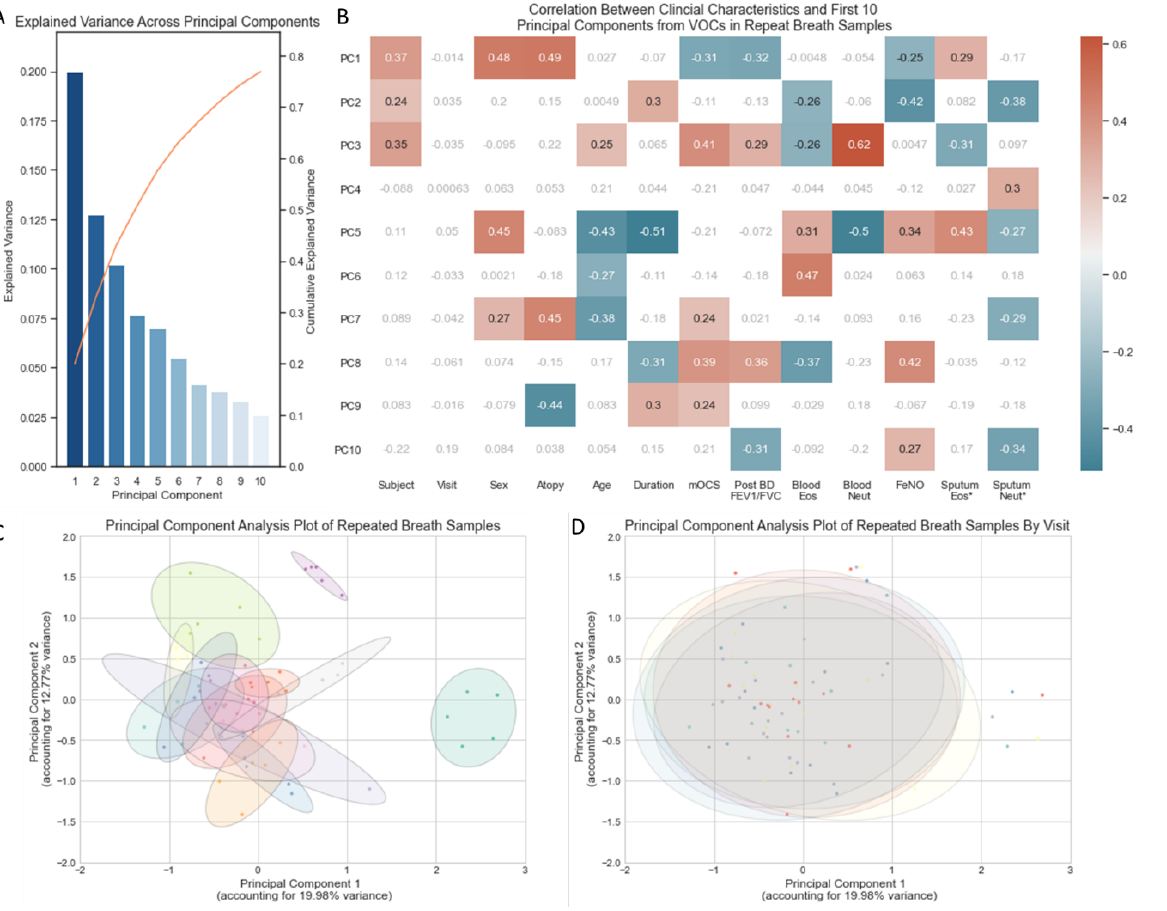
Figure 1. ( A ) Bar chart of the explained variance captured by each of the first ten principal components. ( B ) Heatmap of correlation between clinical characteristics and the first 10 principal components (Supplementary Materials Table S1), non-significant correlations in grey/white, positive and negative correlations with p -value < 0.05 in red and blue, respectively. * Sputum Eosinophils and Sputum Neutrophil Percentages log transformed. ( C ) PCA plot of all 70 breath samples with ellipses representing subject identifiers ( n = 14). ( D ) PCA plot of all 70 breath samples (5 samples from 14 subjects) with ellipses representing the day of the week (Monday, Tuesday, Wednesday, Thursday, Friday) on which the sample was collected. Volatile organic compounds (VOCs), principal component (PC), maintenance oral corticosteroid treatment dose (mOCS), post bronchodilator ratio between forced expiratory volume in 1 s and forced vital capacity (Post BD FEV1/FVC), eosinophils (Eos), neutrophils (Neut), Fraction of exhaled Nitric Oxide